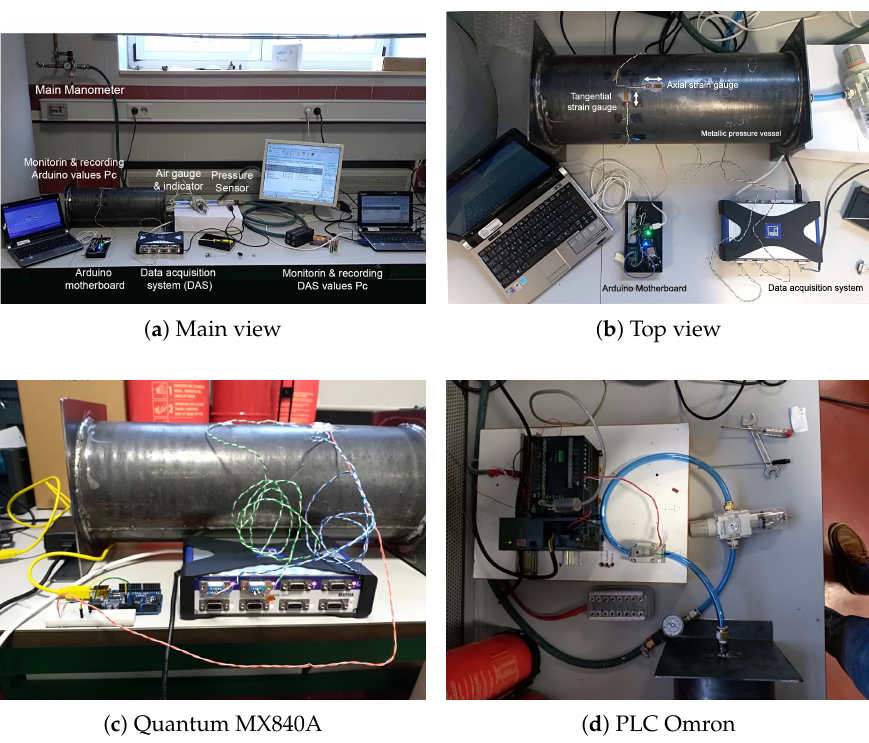
Figure 3. Overview of the pressure measurement equipment.